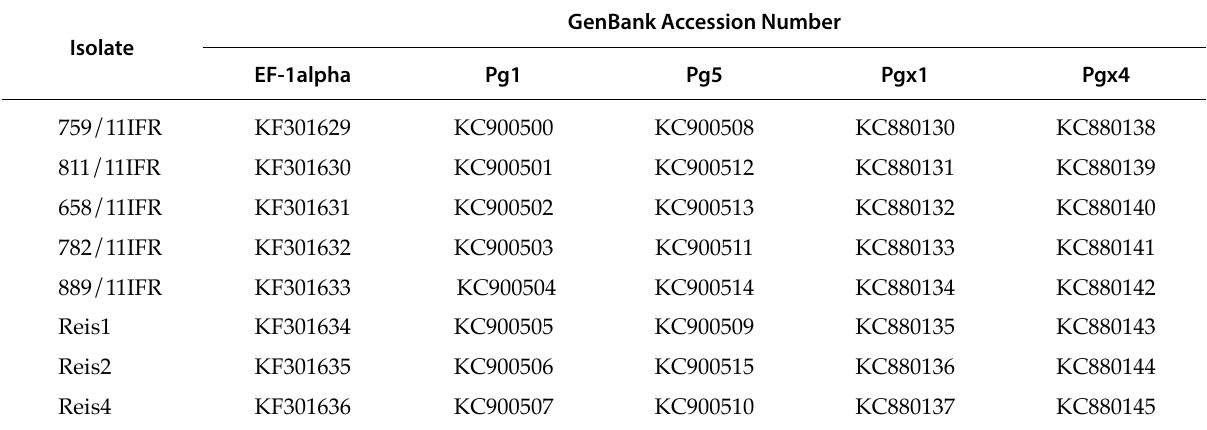
GenBank Accession